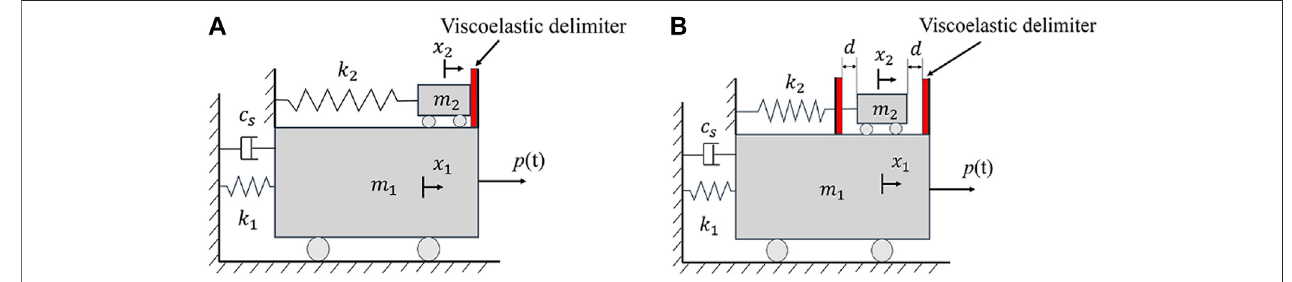
FIGURE 1 | Typical con fi guration of the pounding tuned mass damper (PTMD): (A) Double-sided PTMD; (B) Single-sided